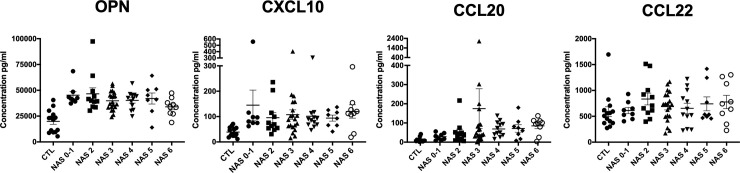
Plasma levels of osteopontin (SPP1) and several chemokines in normal control subjects (n = 14) and patients with NAFLD (n = 67).P < 0.0001 comparing normal to NAFLD groups for OPN and CXCL10.